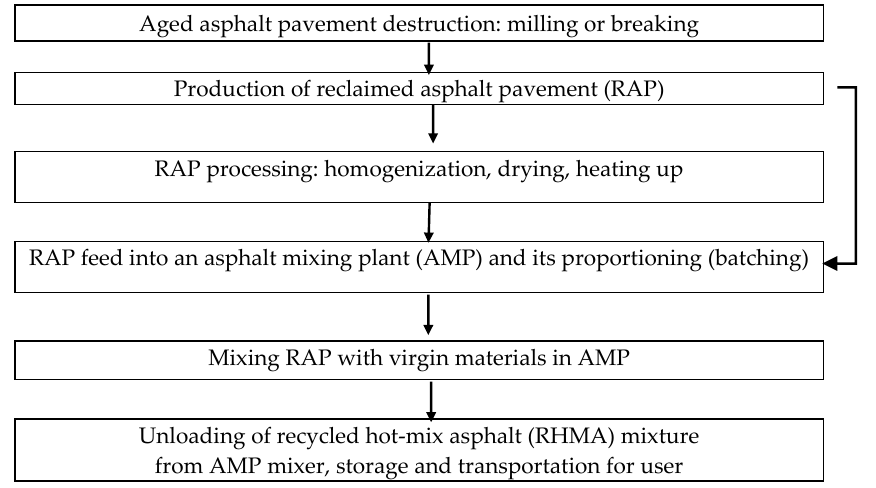
Figure 2. Production operations of the in-plant recycling process of aged asphalt pavement.